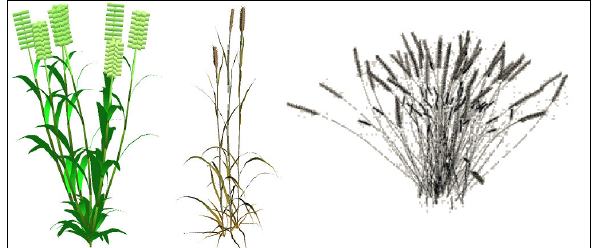
Figure 2. Comparison of three wheat object models. GreenLab (left), XFrog (centre), Arbaro